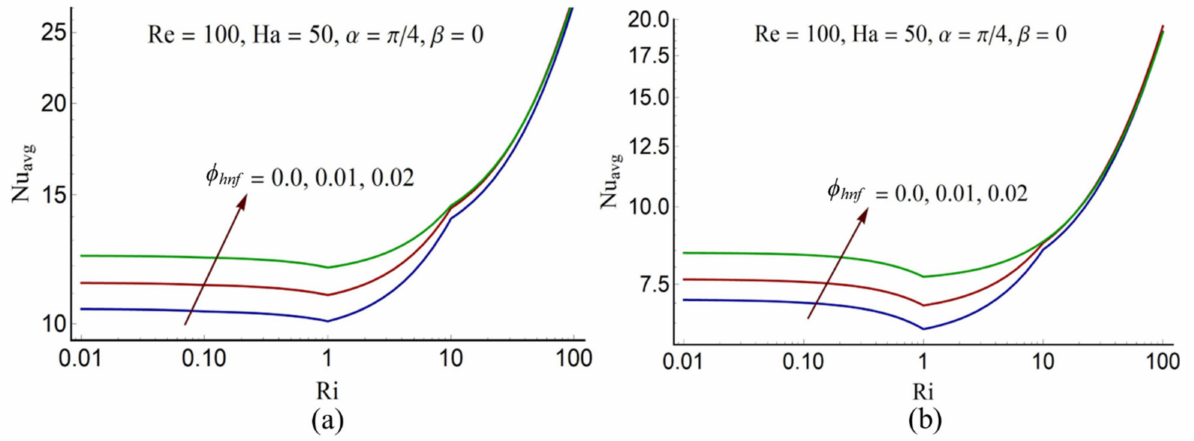
Figure 10. Effect of nanoparticles concentration φ hnf on Nu avg ( a ) at the surface of circular heater ( b ) on the horizontal wall.